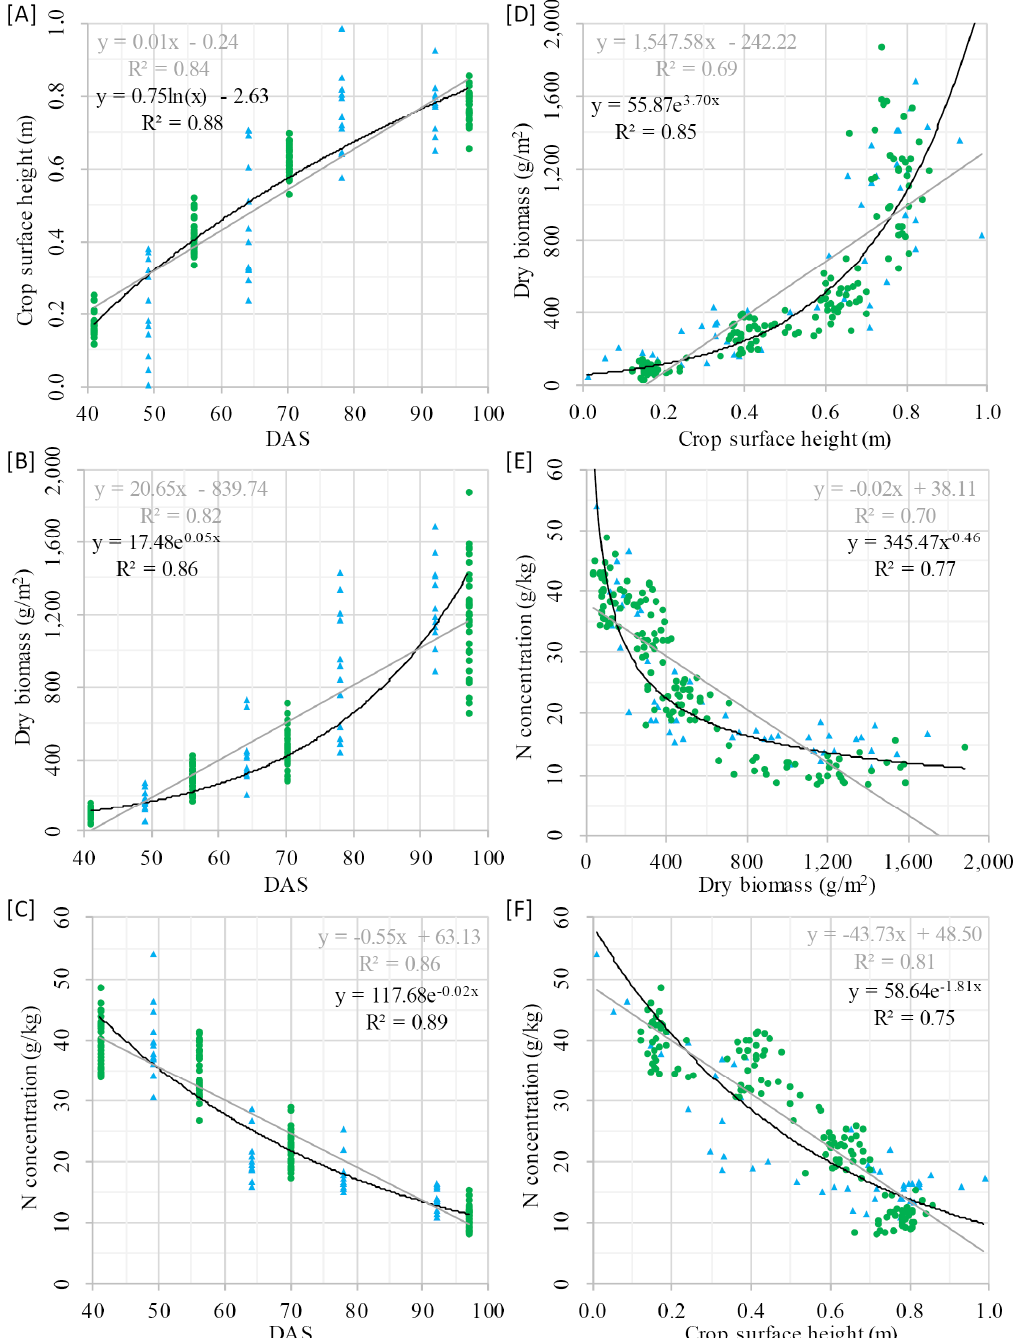
Figure 4. Blue triangles and green dots represent the values of 2013 and 2014, respectively, with linear (light grey) and the best-fitting (black) regression lines. [ A ]–[ C ]: Scatterplots of the crop traits vs. day after seeding (DAS). [ D ]–[ F ]: Crop traits plotted against each